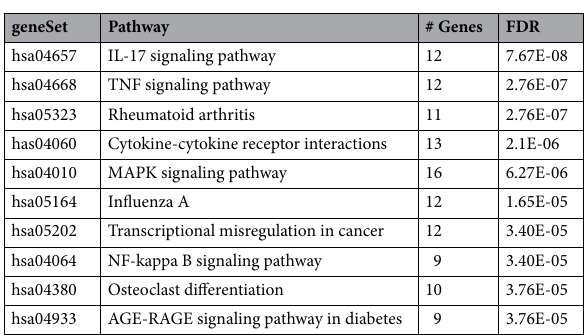
Table 4. Gene set enrichment analysis: top upregulated